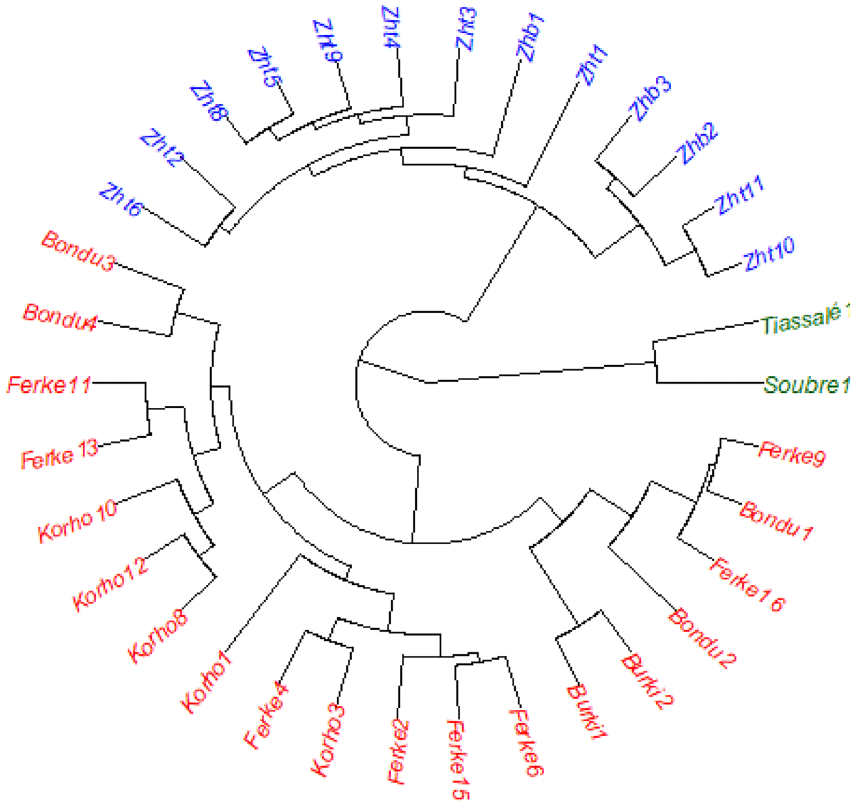
Figure 1. Circular phylogenetic tree of the 34 morphotypes of C. moschata grown in Cote d’Ivoire. The three colors define the grouping of the morphotypes according to their morphological and phenological